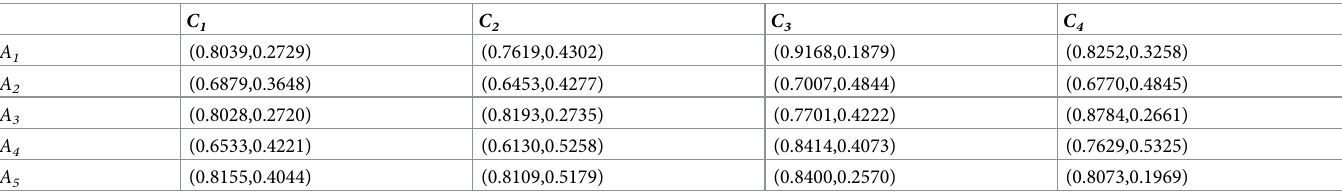
Table 4. Collective q -rung orthopair fuzzy decision